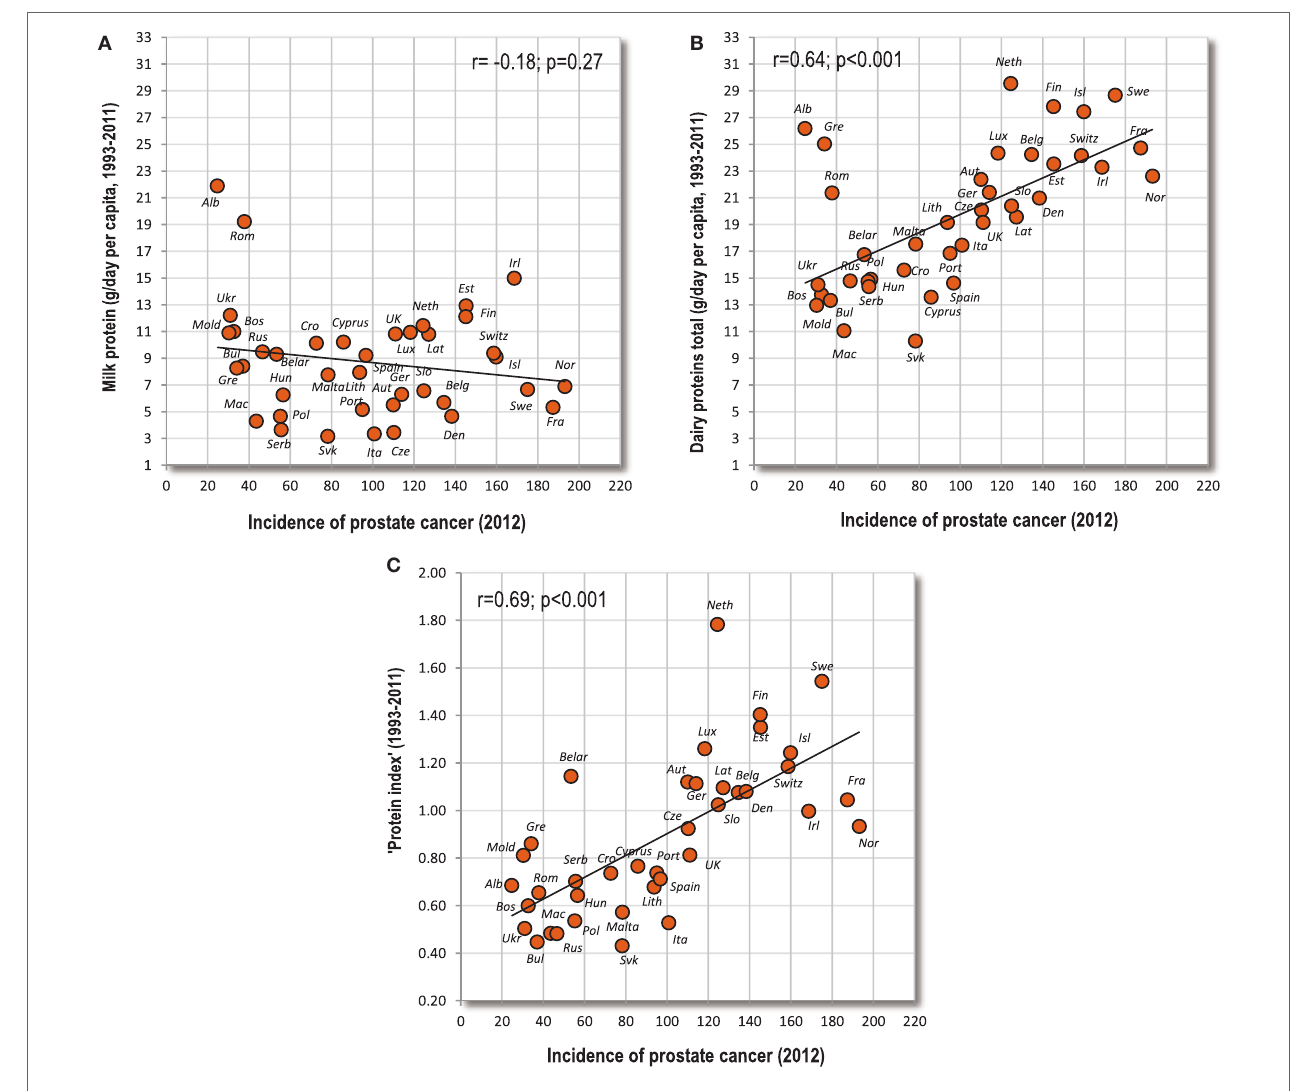
FigUre 12 | (a–c) Relationship between various variables associated with dairy consumption and the incidence of prostate cancer. Note: “Protein index” is an indicator of protein quality, and expresses the mean ratio between dairy and wheat